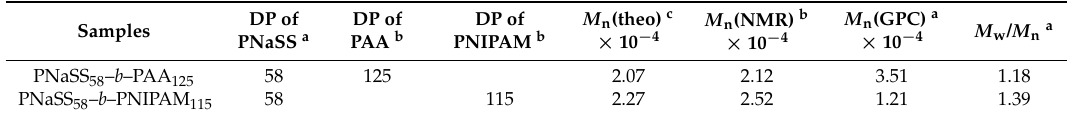
Table 1. Degrees of polymerization (DP) of PNaSS, PAA, and PNIPAM blocks, and number-average molecular weights ( M n ), and molecular weight distributions ( M w / M n ) of the diblock copolymers.